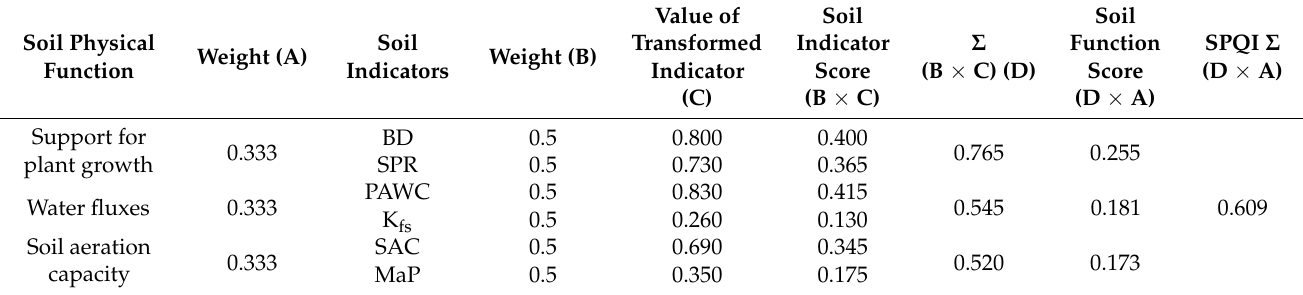
Table 3. An example of the framework applied to develop the Soil Physical Quality Index (SPQI) for assessing the effects of wheel traffic and soil mechanical intervention in a Rhodic